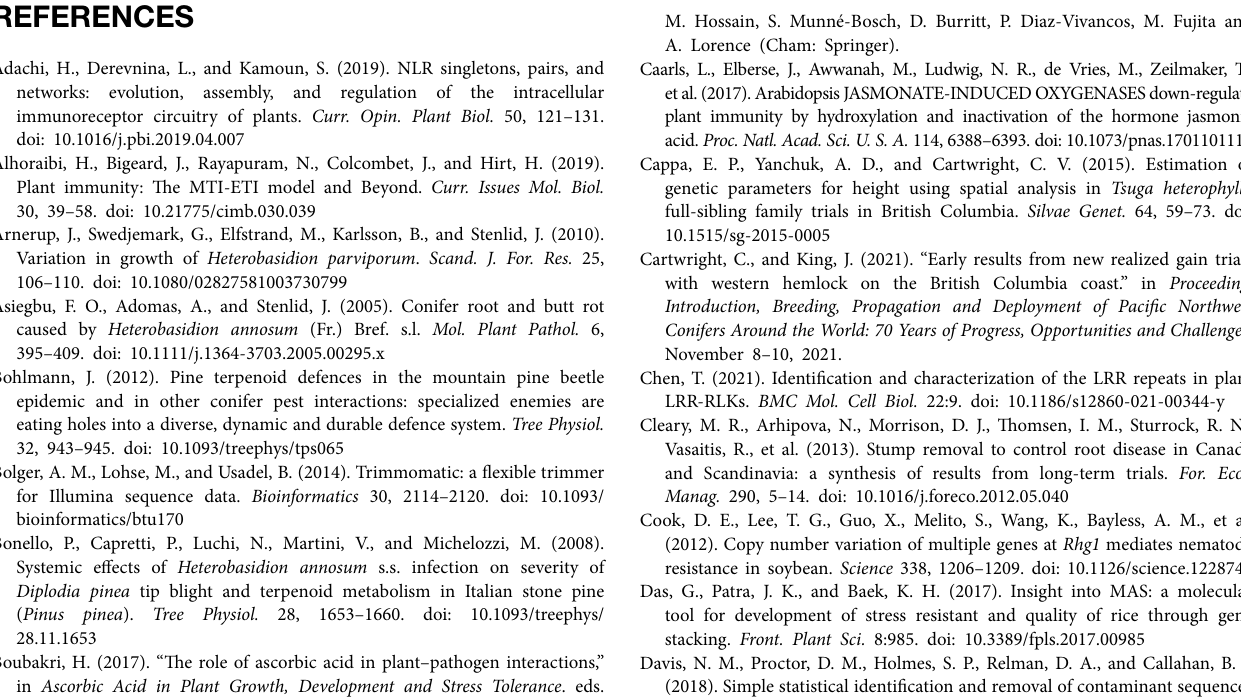
Supplementary Table S1 | A list of seedlings, stem tissues, and cDNA libraries used for RNA-seq analysis. Supplementary Table S2 | Statistics of de-novo assembly of RNA-seq reads to generate a western hemlock reference transcriptome. Supplementary Table S3 | Differentially expressed genes (DEGs) upregulated in seedlings with quantitative resistance (QR) post infection by Heterobasidion occidentale. Supplementary Table S4 | Differentially expressed genes (DEGs) downregulated in seedlings with quantitative resistance (QR) post infection by Heterobasidion occidentale. Supplementary Table S5 | Differentially expressed genes (DEGs) upregulated in susceptible (Sus) seedlings post infection by Heterobasidion occidentale. Supplementary Table S6 | Differentially expressed genes (DEGs) downregulated in susceptible (Sus) seedlings post infection by Heterobasidion occidentale. Supplementary Table S8 | A list of genes used for genetic diversity study.